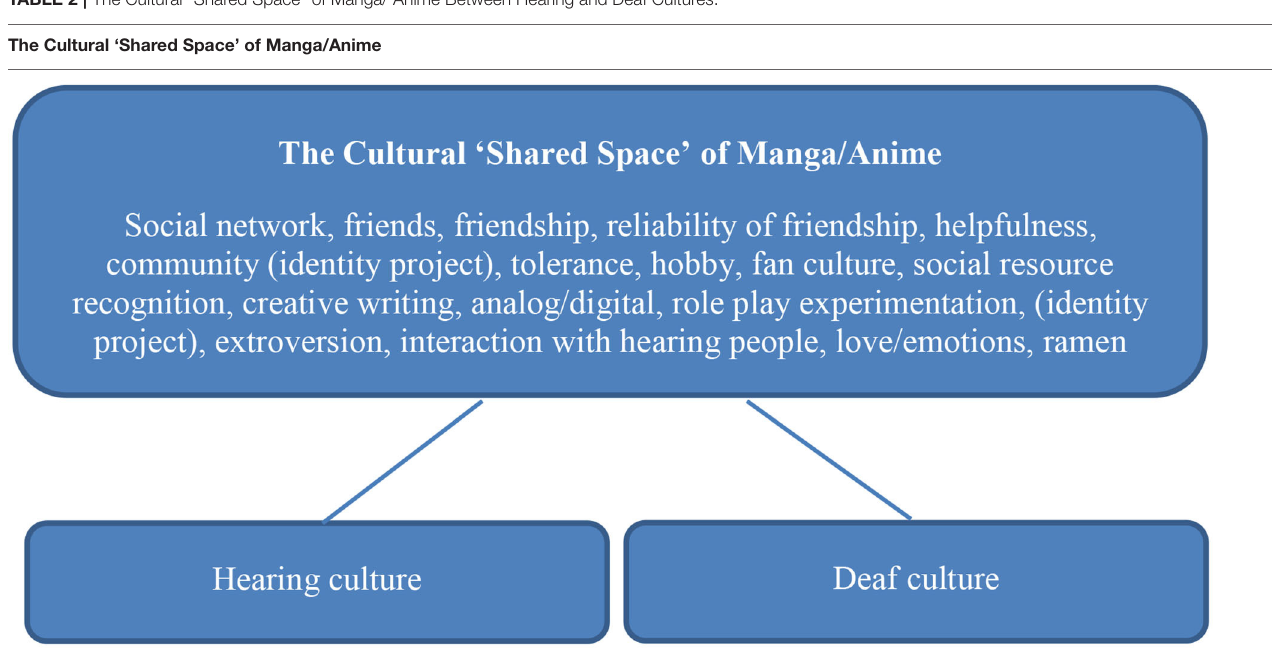
Frontiers in Education |